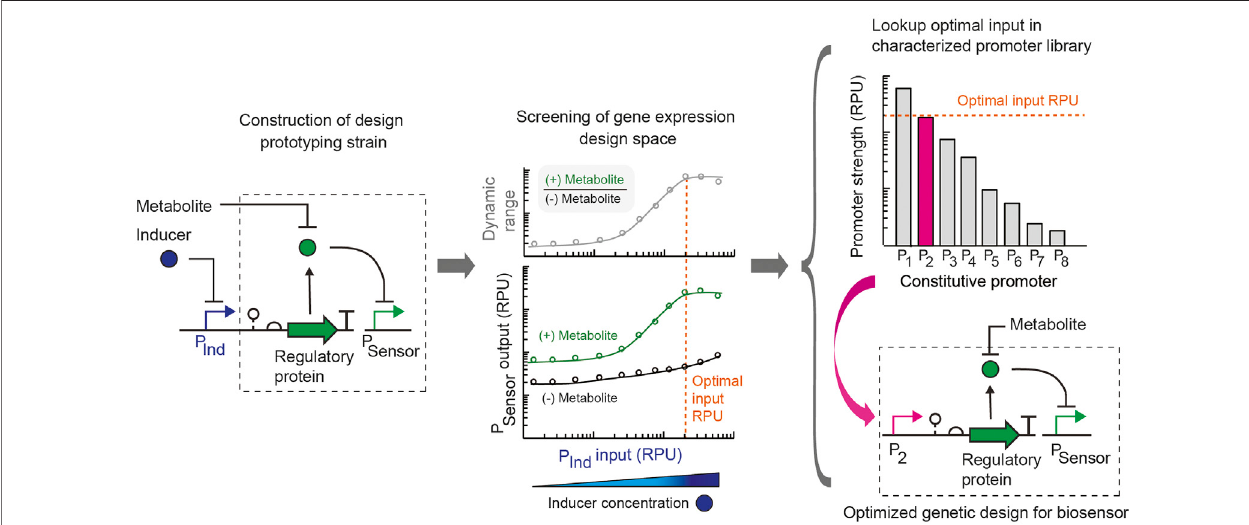
FIGURE 1 | Rapid design prototyping approach for engineering metabolite biosensors. Initially, a design prototyping construct is built for the whole cell biosensor, which uses a tightly-regulated and characterized inducible promoter (P Ind ) to control the expression of the metabolite-responsive transcription regulatory protein. A ribozyme part is used to genetically insulate the design. The sensor output promoter (P Sensor ) is speci fi ed, and the regulator for the P Ind promoter is expressed on the construct.Thetargetforthesensor ’ ssensitivityisselectedbasedonthemetaboliteconcentrationtobedetectedintheapplicationofinterest.Foruseinthehuman gut, the metabolite concentration to be detected in the gut is speci fi ed. Then, the sensor prototyping design is assayed in parallel experiments for the range of transcription regulator expression levels for each condition with additionofthe target metabolite concentration (green) and without the addition of the metabolite (black). Thesensoroutputismeasuredinstandardrelativepromoterunits(RPU).Fromthisdataset,anoptimalpromoterinputvalue(orangedottedline)isselectedthatachieves therequiredsensitivity,optimaldynamicrange(ratioofONpromoteroutput/OFFpromoteroutput)andsuitablepromoteroutputintheactivatedandunactivatedstates. Fromalibraryofconstitutivepromoterscharacterizedinstandardunits(RPU),apromoterpartthatmatchestheoptimalinputvalue(orangedottedline)isselectedfroma library and used to replace the inducible promoter to build the fi nal engineered sensor design. The fi nal design is optimized for the speci fi ed sensitivity of the